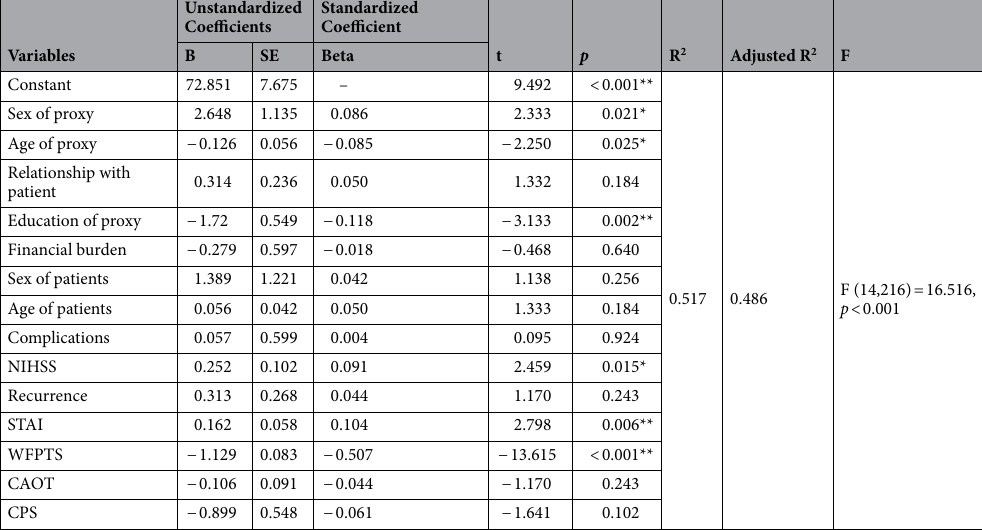
Table 4. Ridge regression analysis results (Y: C-DCS). * p < 0.05 ** p < 0.01. Dummy variables were set for categorical variables. Sex: 1 = male, 2 = female; Education degree: 1 = primary and below, 2 = junior middle school, 3 = senior high school, 4 = bachelor, 5 = master; Relationship with patient: 1 = sons or daughters, 2 = spouse, 3 = parents, 4 = brother or sister, 5 = others; Economic burden: 1 = none, 2 = mild, 3 = middle, 4 = large.